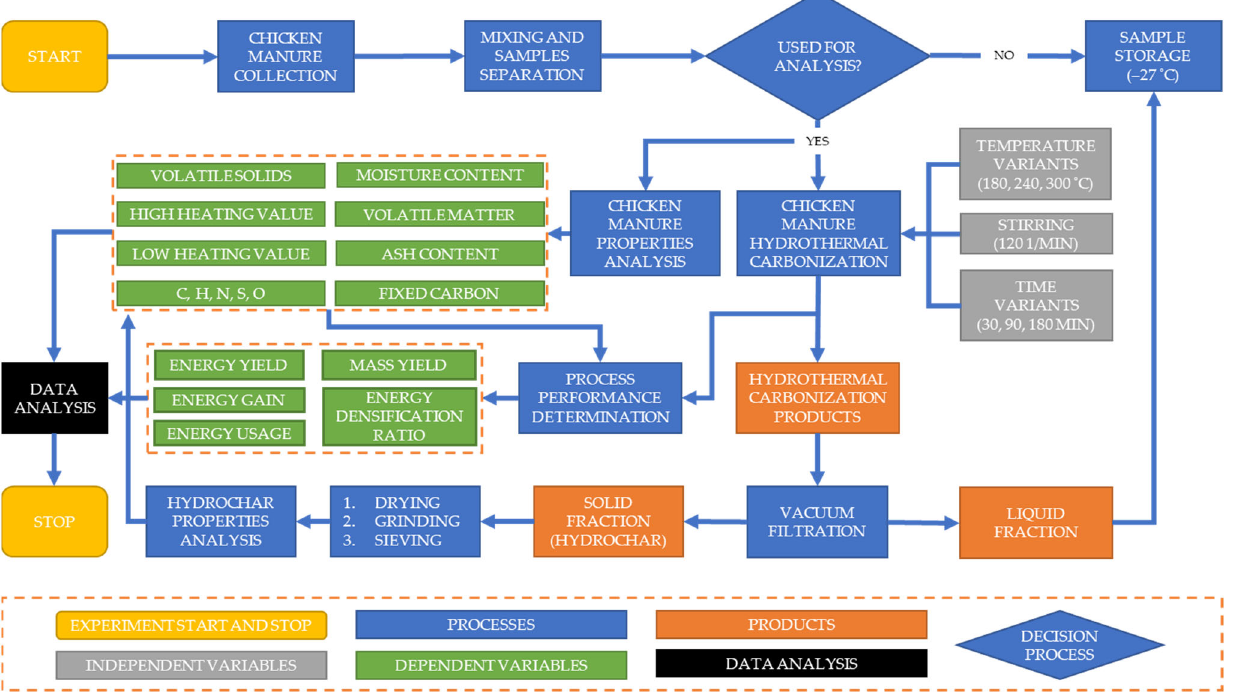
Figure 1. Schematic overview of the experimental